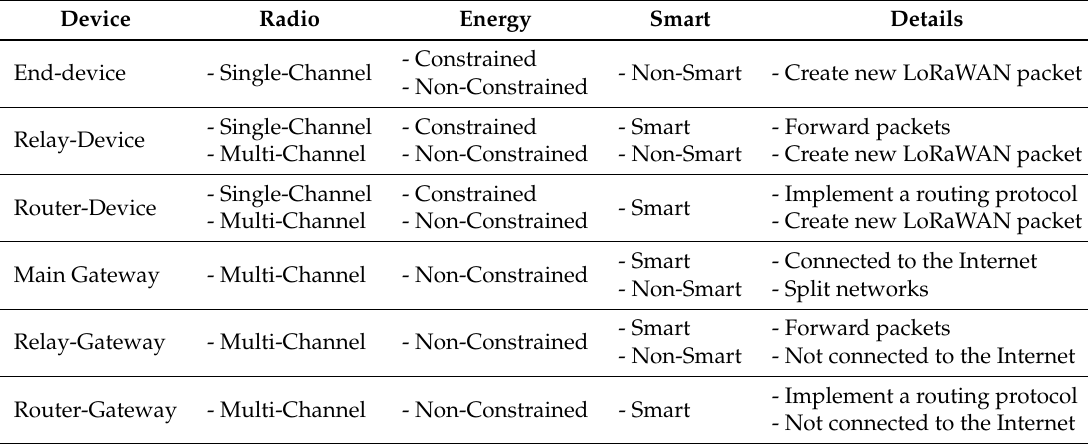
Table 3. Devices classification.